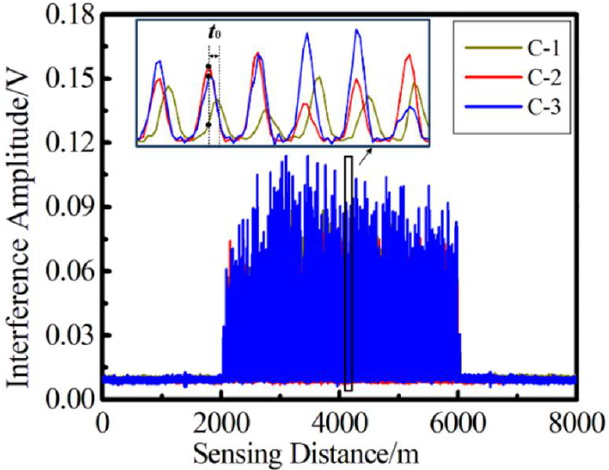
Figure 4. Echo pulse train for three-way signal of uwFBG array with 800 sensors.